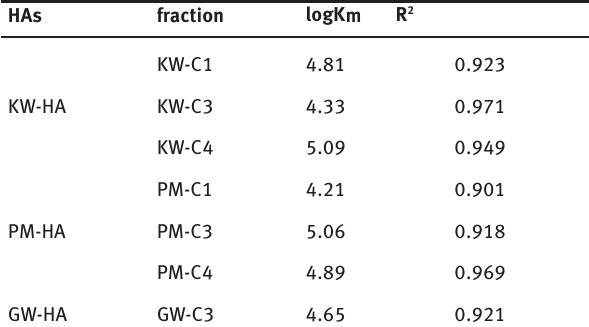
Table 3 Binding parameters between Cd(II) and components derived from three HAs calculated by the modified Stern-Volmer equation